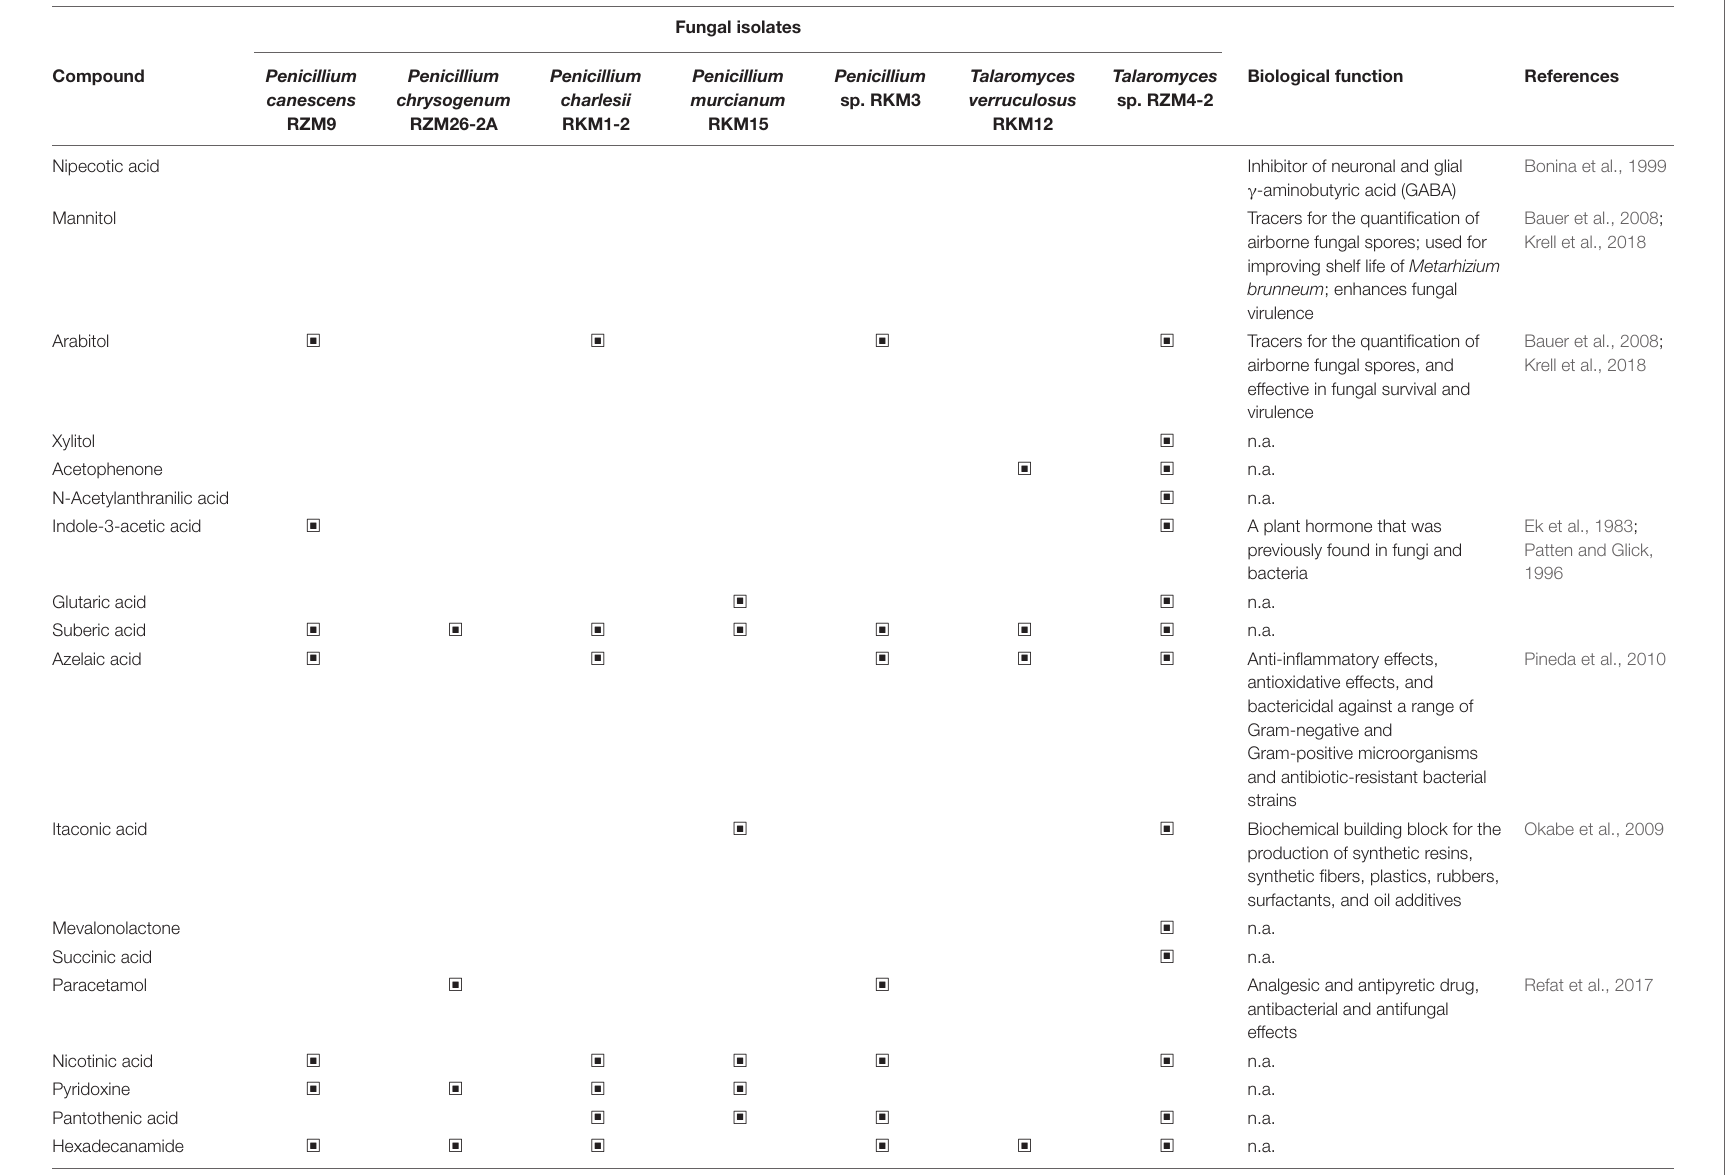
TABLE 2 | Secondary metabolite profiles of endophytic fungal isolates assigned to Penicillium spp. and Talaromyces spp. that were identified in the cultivation medium.